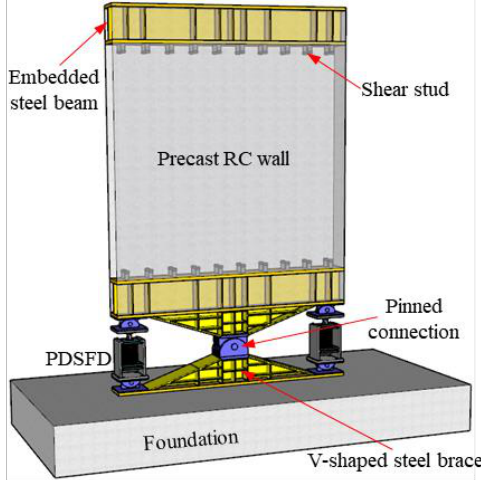
Figure 1. Schematic diagram of the presented PSCRSW.